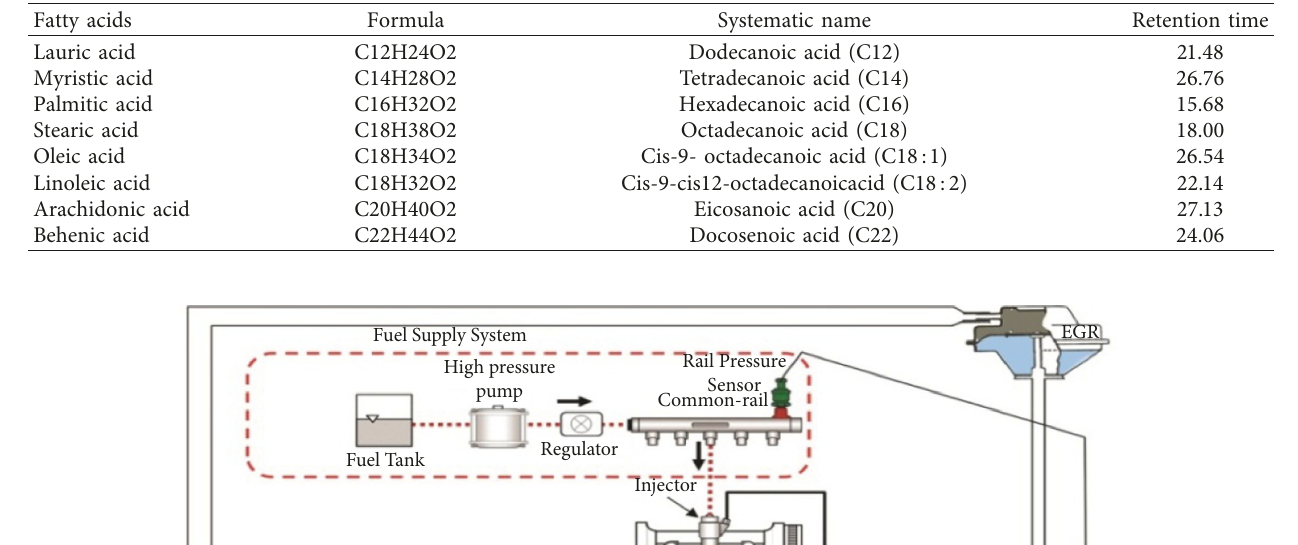
Figure 3: GC-MS analysis of Prosopis juliflora oil. Table 2: GC-MS analysis composition of Prosopis juliflora oil.